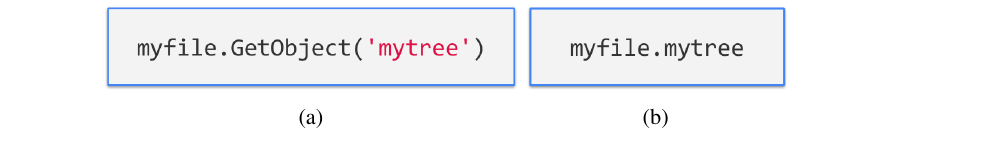
Figure 3: Two ways of getting the TTree stored in a ROOT file in PyROOT: 3a) the C ++ -like way, 3b) the pythonic way.